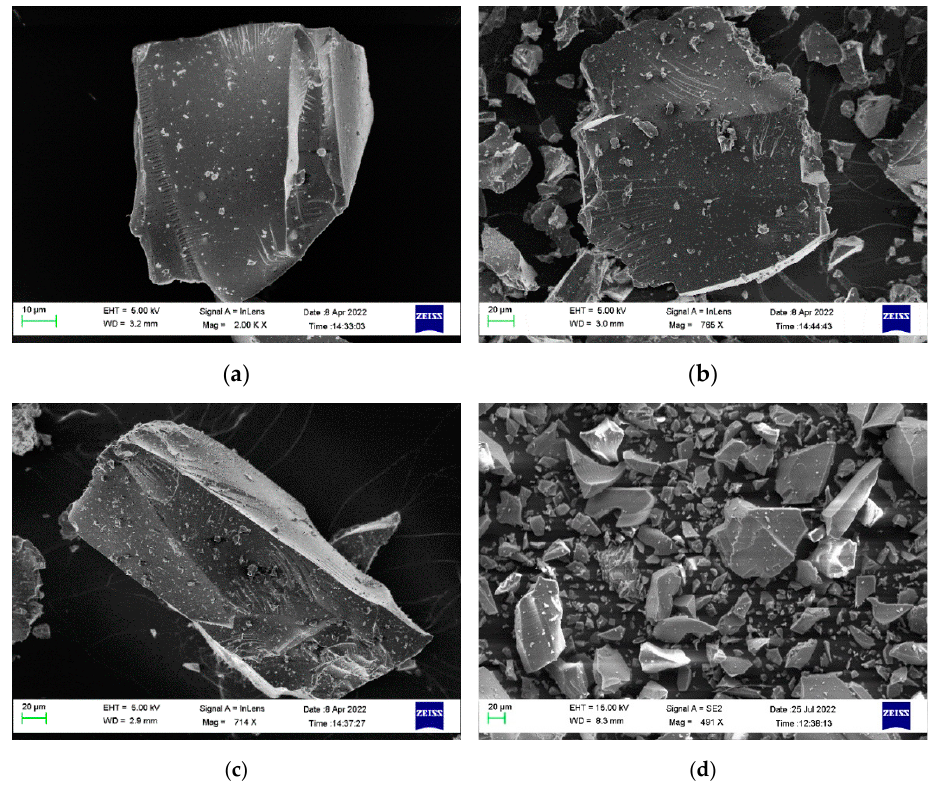
Figure 1. Micrographs obtained for ( a ) XGS; ( b ) XGS-Fe-Im-0.4; ( c ) XGS-Fe-Pol-0.1; and ( d ) XGS-Fe- Pol-0.3.